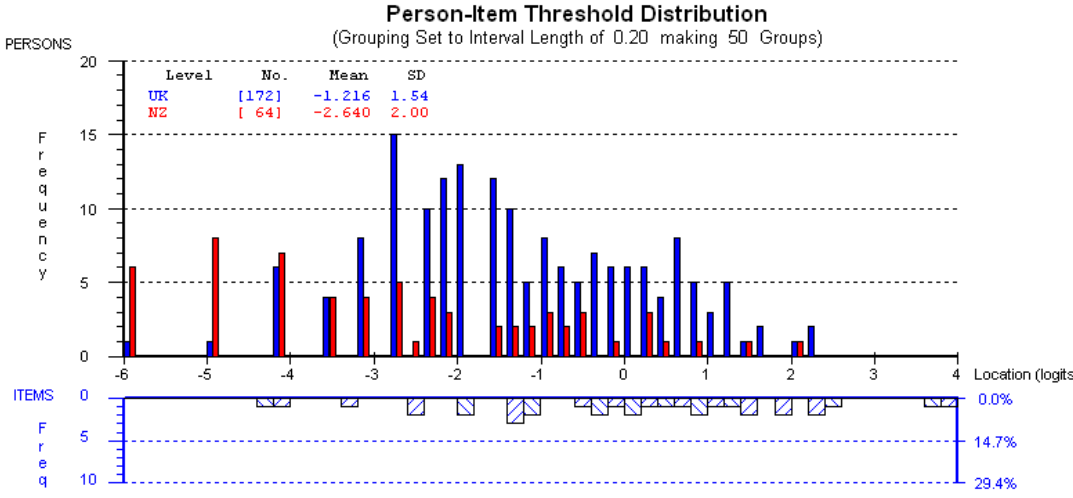
Figure 1. Graph showing the targeting of the MIQ in the NZ sample.